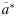
Variability in phytoplankton absorption spectra, incubator light quality and spectrally-weighted absorption.A) Chl a-specific in vivo absorption spectra [a*(λ)] at sampled stations and depths, B) spectral irradiance of the incubator light sources [E(λ)], and C) the spectrally-weighted chl a-specific absorption of phytoplankton at GF7 (5m), corrected for E(λ) in the water bath (green) and for the internal light source of the PhytoPAM (blue). Integrated values for a* and a¯* are given in Table 2.